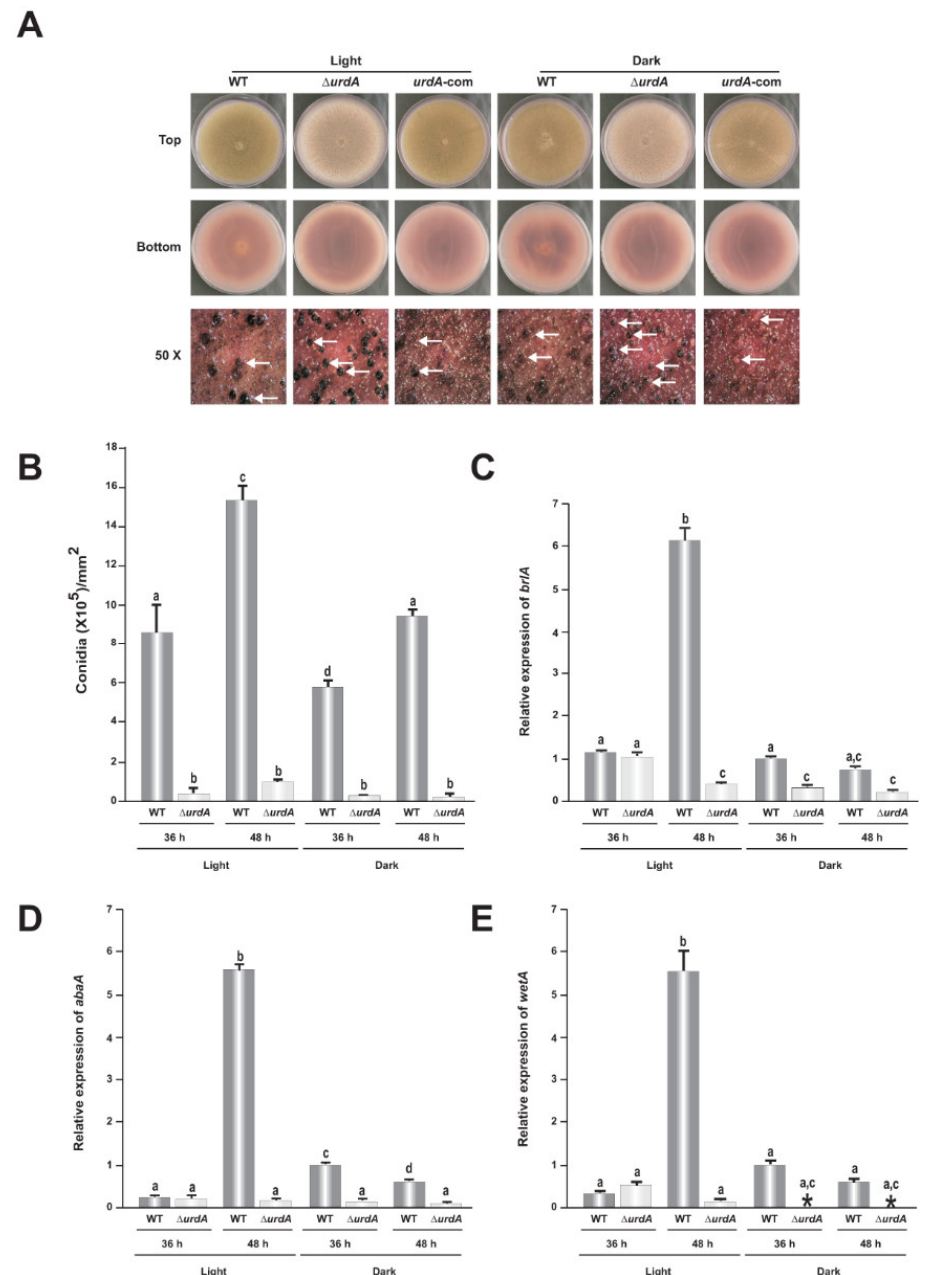
Figure 3. urdA promotes asexual development. ( A ) Wild type (WT), Δ urdA and urdA ‐complementation ( urdA ‐com) strains were point‐inoculated on glucose minimal medium (GMM) plates and incubated for 7 days in light and dark. Micrographs were taken with a Leica MZ75 dissecting microscope attached to a Leica DC50LP camera at 50× magnification after spraying the plates with 70% ethanol to enhance visualization of cleistothecia. The white arrows indicates the cleistothecia. ( B ) Quantification of conidiophores in 36 h and 48 h cultures grown on solid GMM in light and dark. Top‐agar inoculated cultures were used to analyze the expression of brlA ( C ) abaA ( D ) and wetA ( E ). Values are means of three replicates and Error bars indicate standard errors. Different letters above the bar graphs represent significantly different values ( p ≤ 0.05).